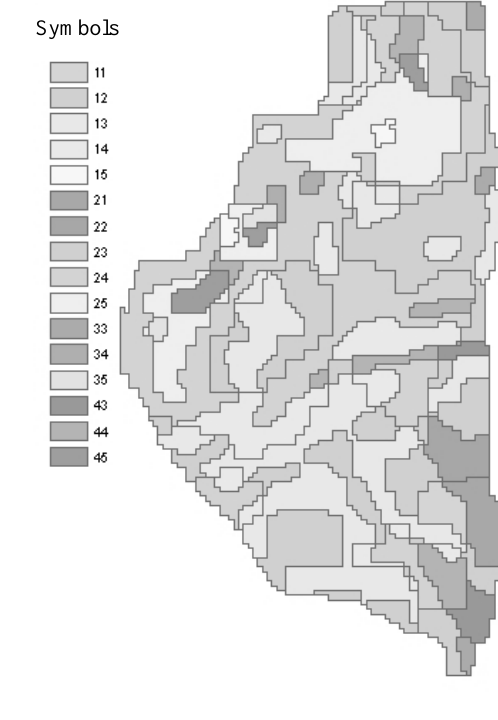
Fig 8. Relief roughness